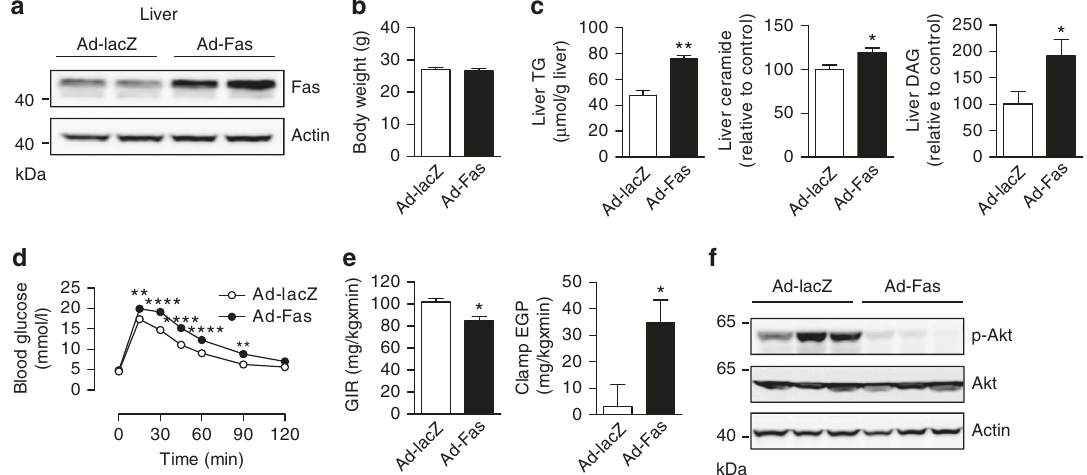
Fig. 2 Adenovirus-mediated hepatic overexpression of Fas induces hepatic steatosis and hepatic insulin resistance. a Protein levels of Fas in total liver lysate of mice injected with adenoviruses expressing either Fas (Ad-Fas) or a control vector (Ad-lacZ). b Body weight of mice 12 days after adenovirus injection, n = 7. c Liver TG ( n = 5), ceramide, and DAG (Ad-LacZ, n = 6; Ad-Fas, n = 7) levels are shown. d Intraperitoneal glucose tolerance test ( n = 7), e glucose infusion rate (GIR), and endogenous glucose production (EGP) during hyperinsulinemic-euglycemic clamps ( n = 4) in mice 12 days after injection of Ad-lacZ or Ad-Fas are depicted. f Representative western blots of total liver lysate harvested from mice 15 – 16 days after injection of Ad-lacZ or Ad-Fas. Values are expressed as mean ± s.e.m.; * p < 0.05, ** p < 0.01, and **** p < 0.0001. Statistical tests used: t -test for ( b , c (TG, ceramide), e ); Mann – Whitney for ( c (DAG)); ANOVA for ( d